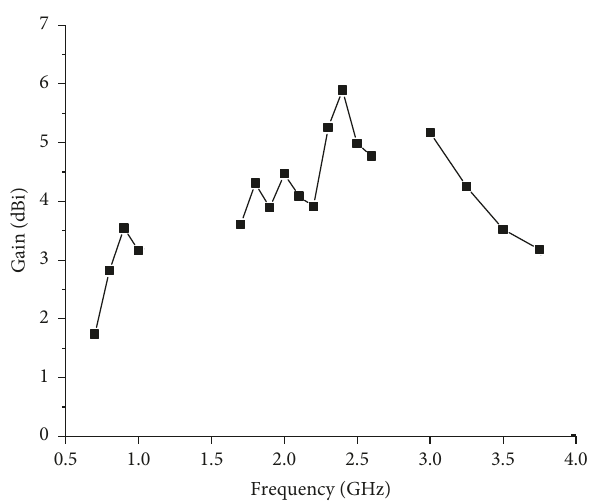
Figure 12: Measurement of the gain of the two-branch vehicle antenna. Table 2: Comparison of similar